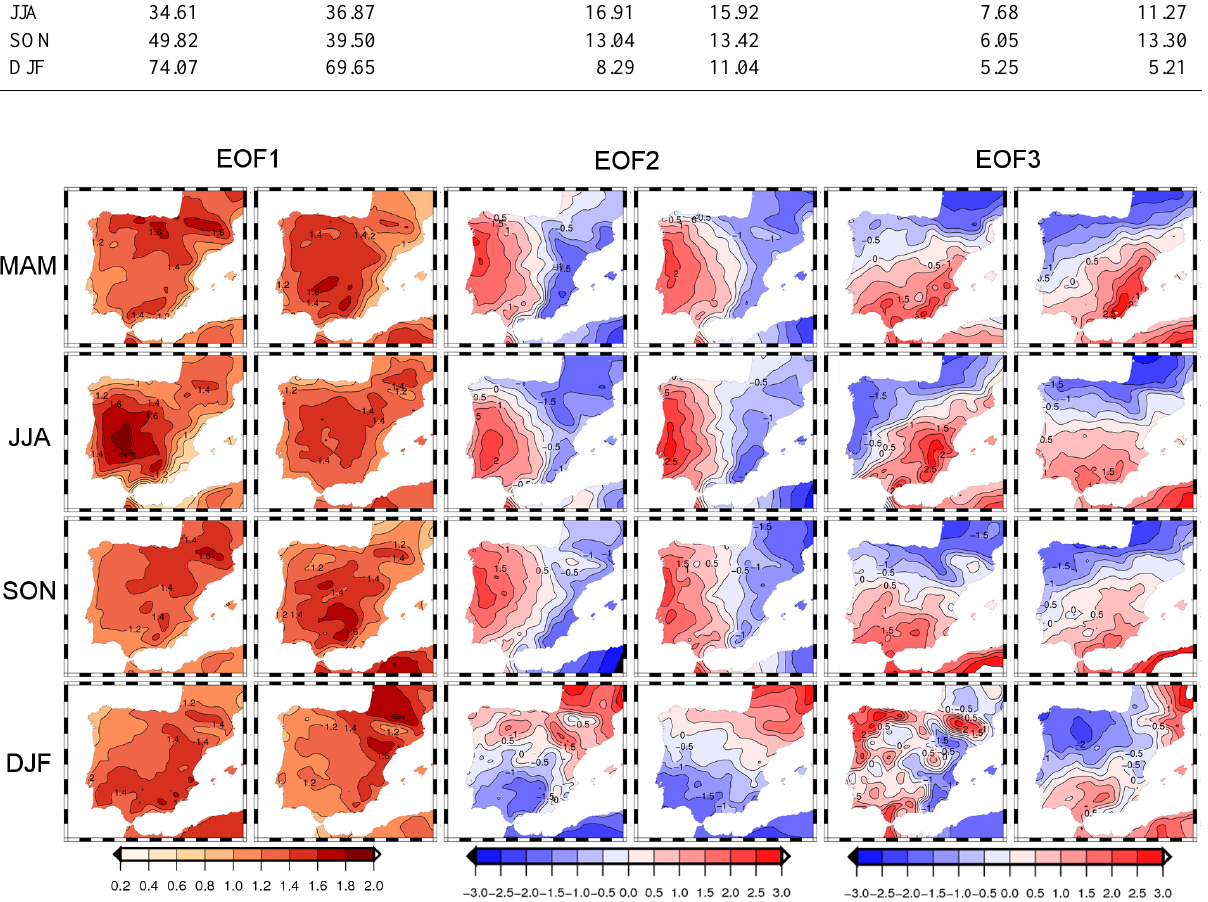
Fig. 8. Normalised EOF patterns obtained from the seasonal mean series of SAT for the period 1961–1990 in the simulations ECHO-G+MM5 and ERA40+MM5.